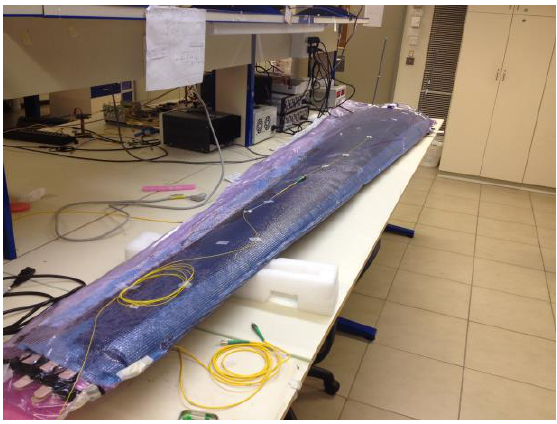
Figure 5. A model wing of an unmanned aerial vehicle, built with an outer skin of carbon-fiber and epoxy composite, with embedded sensing fibers.